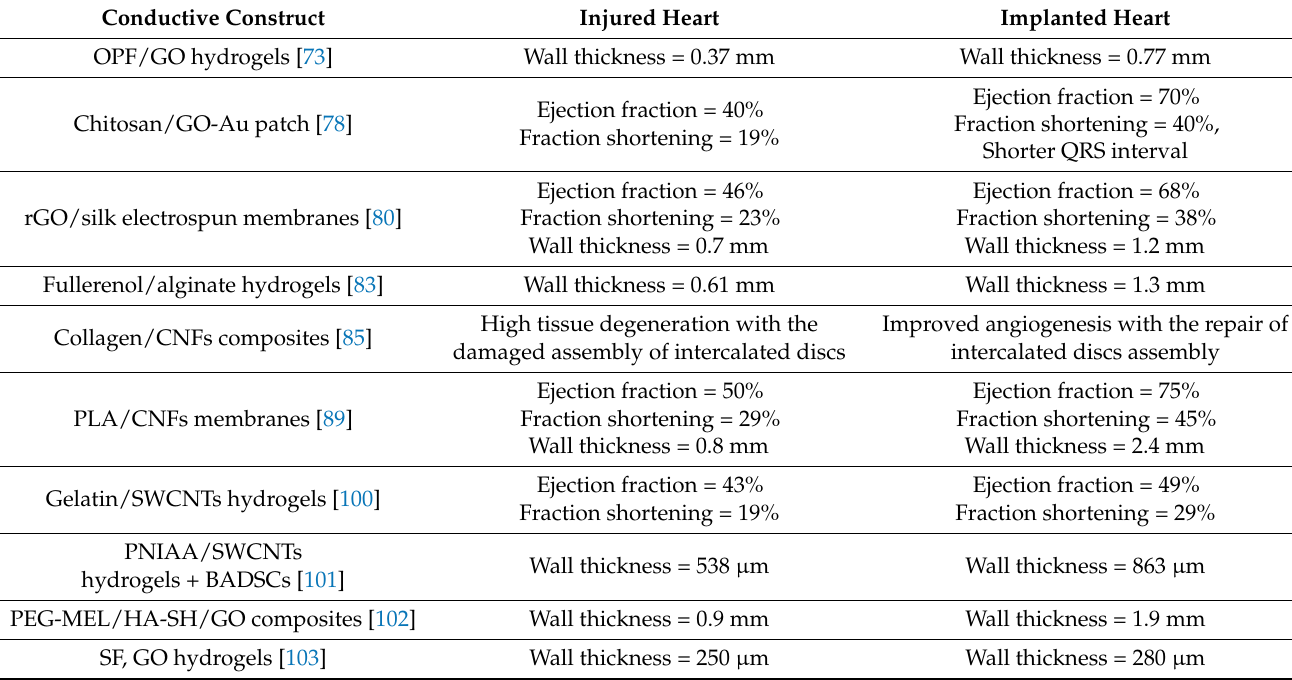
Table 5. In vivo efficacy of CNMs-based conductive scaffolds to repair the ischaemic heart tissue in